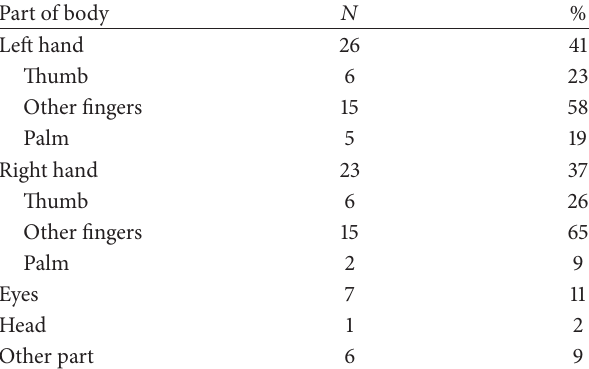
Table 1: Parts of body affected by